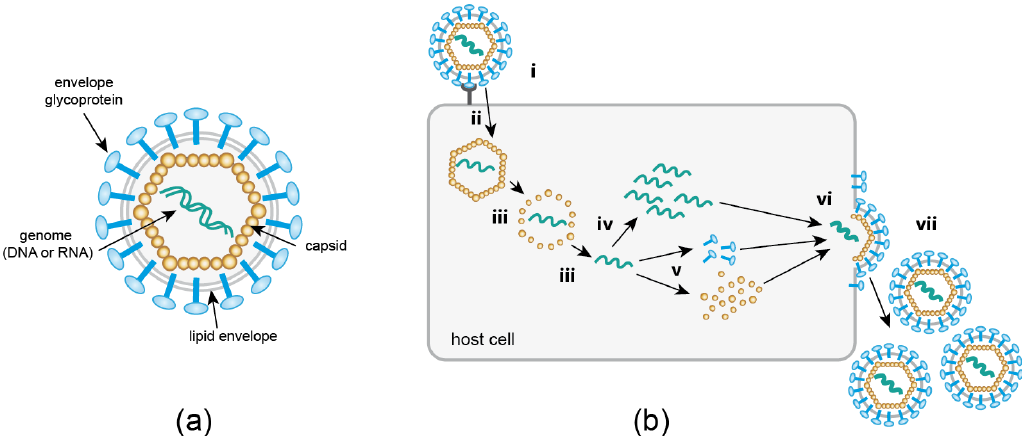
Figure 1. ( a ) Basic components of a virus particle. Non-enveloped viruses consist of nucleic acid encased in a proteinaceous capsid. Enveloped viruses are further surrounded by a lipid envelope derived from a host cell membrane, studded with viral glycoproteins required for cell attachment and entry. ( b ) Generic replication cycle of eukaryotic viruses. Details of individual steps vary greatly between different virus families. Receptor mediated attachment (i) is followed by cytosolic entry (ii), which may occur via an endocytotic process or—for enveloped viruses—membrane fusion. An uncoating step (iii) releases the viral genome, which is replicated (iv) either in the cytosol or in the nucleus of the host cell. Viral proteins are produced by the host cell translation machinery (v). Finally, newly synthesized virion components assemble into progeny particles (vi); this may occur either within the cell or directly underneath the plasma membrane. Release (vii) of progeny virus occurs via cell lysis, exocytosis or budding at the cell membrane.